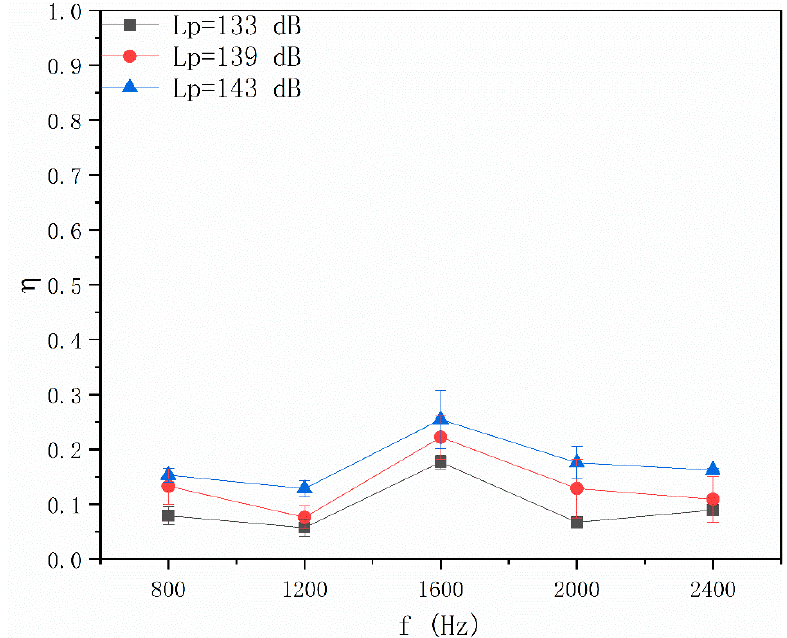
Figure 8. Reduction ratio of 0.5- µ m particles under di ff erent acoustic conditions.